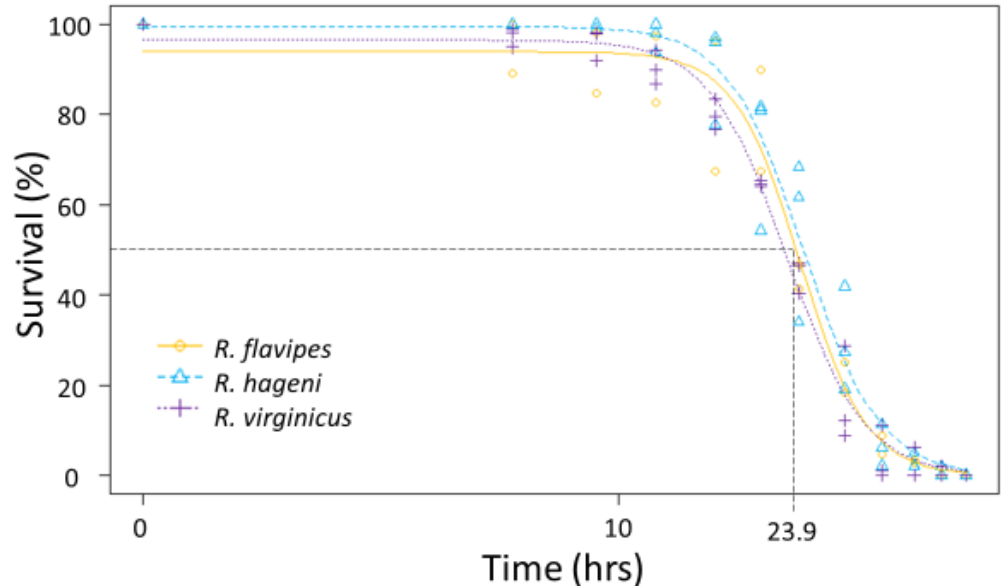
Figure 3. Desiccation tolerance for multiple colonies of Reticulitermes flavipes , R. hageni , and R. virginicus . Lethal time 50% (LT 50 ), or the time at which 50% of individuals died from desiccation is indicated by the dashed line. The x axis is log-scaled.